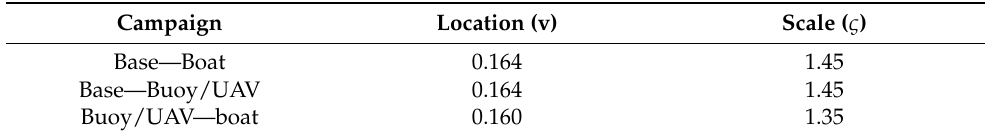
Table 2. Values of data of the small-scale fading